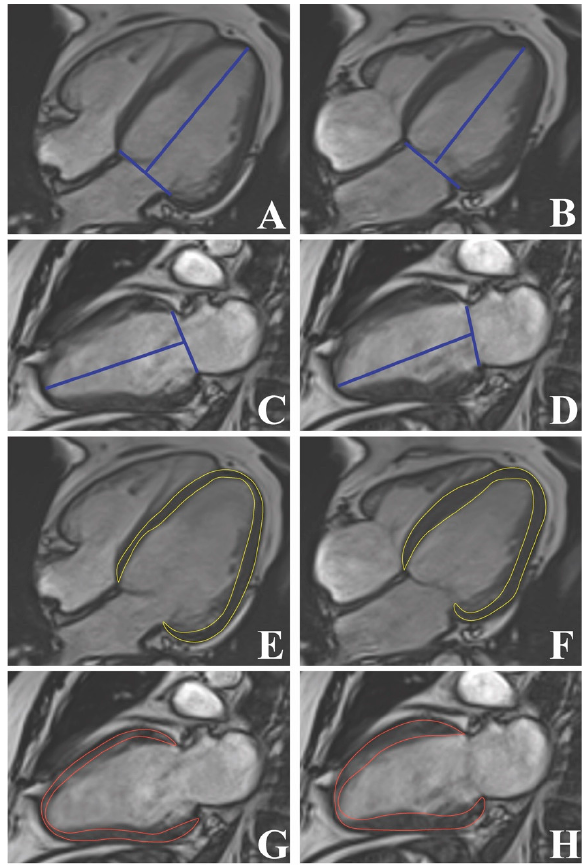
Figure 2. Left ventricular geometry and strain by cine-cardiac magnetic resonance imaging: Left ventricle long-axis strain ( A – D ) and sphericity index ( E – H ). LV long-axis strain (Figure 2) is a novel indicator of LV systolic function, which can be easily determined by FT-CMR, having high reproducibility and considerable predictive ability [117]. Recently, Leng et al. have shown that standard cine-CMR can also deploy effective and reproducible LV systolic parameters, including LV long-axis strain [118]. Cine-CMR-derived LV long-axis strain has proven non-inferior to FT-CMR-derived one in identifying patients with various cardiomyopathies, being also more time-efficient [119]. Moreover, it was significantly impaired in diabetic patients without clinically overt cardiac disease, even after adjustment for clinical and biological covariates [92]. In the MESA cohort population, impaired LV long-axis strain significantly predicted congestive heart failure, cardiovascular death, stroke, and myocardial infarction, even in subjects without clinically overt cardiovascular illnesses [120]. Likewise, the utility of LV long-axis strain for the prediction of cardiac outcome has also been shown in cardiac amyloidosis, aortic stenosis, and dilated cardiomyopathy [113,117,121]. In addition, it may also improve risk stratification in patients with non-ischemic dilated cardiomyopathy [122]. As for patients with myocardial infarction, impaired LV long-axis strain independently predicted major adverse cardiovascular events at the one-year follow-up